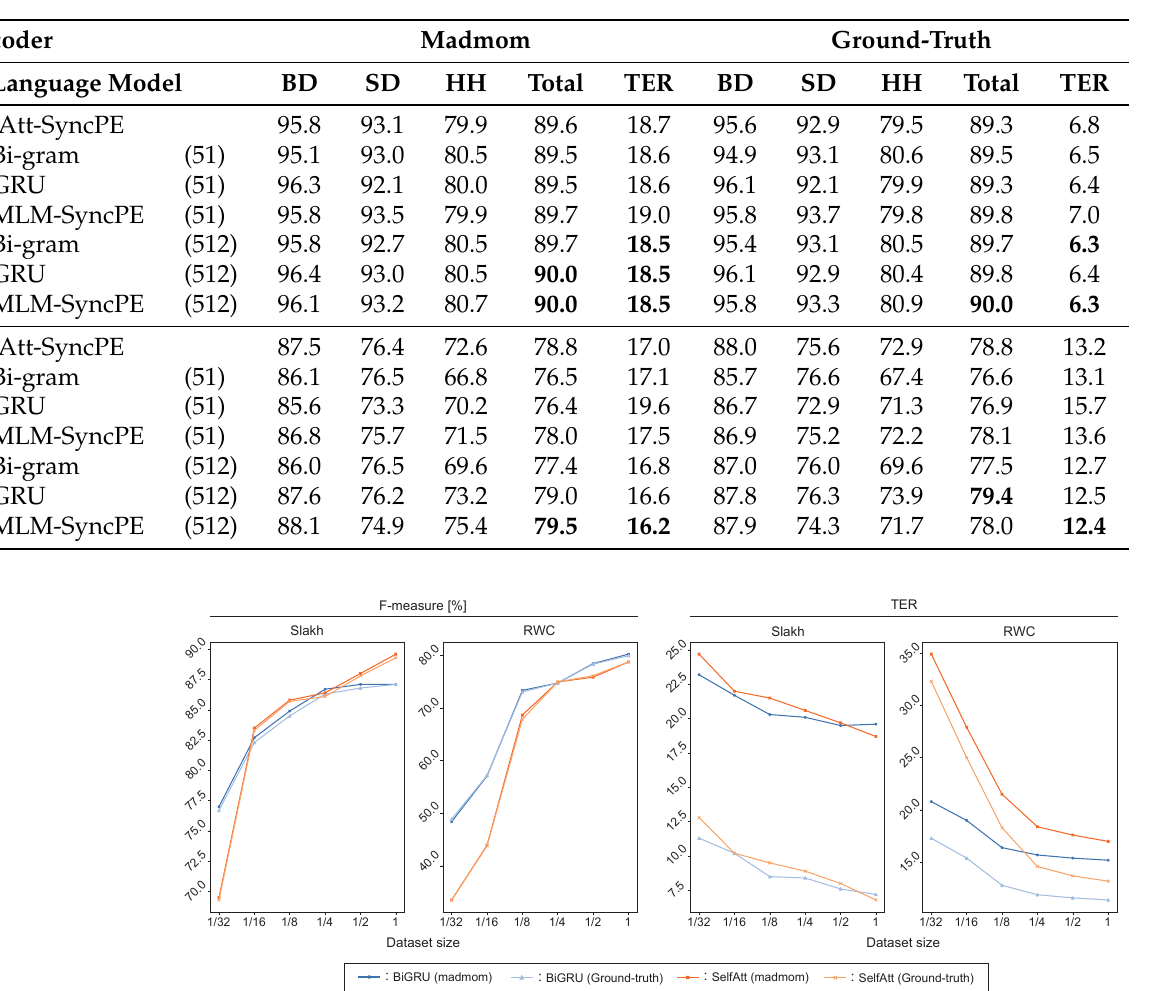
Table 8. F-measures (%) and TERs obtained by CNN-SelfAtt-SyncPE regularized by the language models pretrained from 51 or 512 external drum scores.